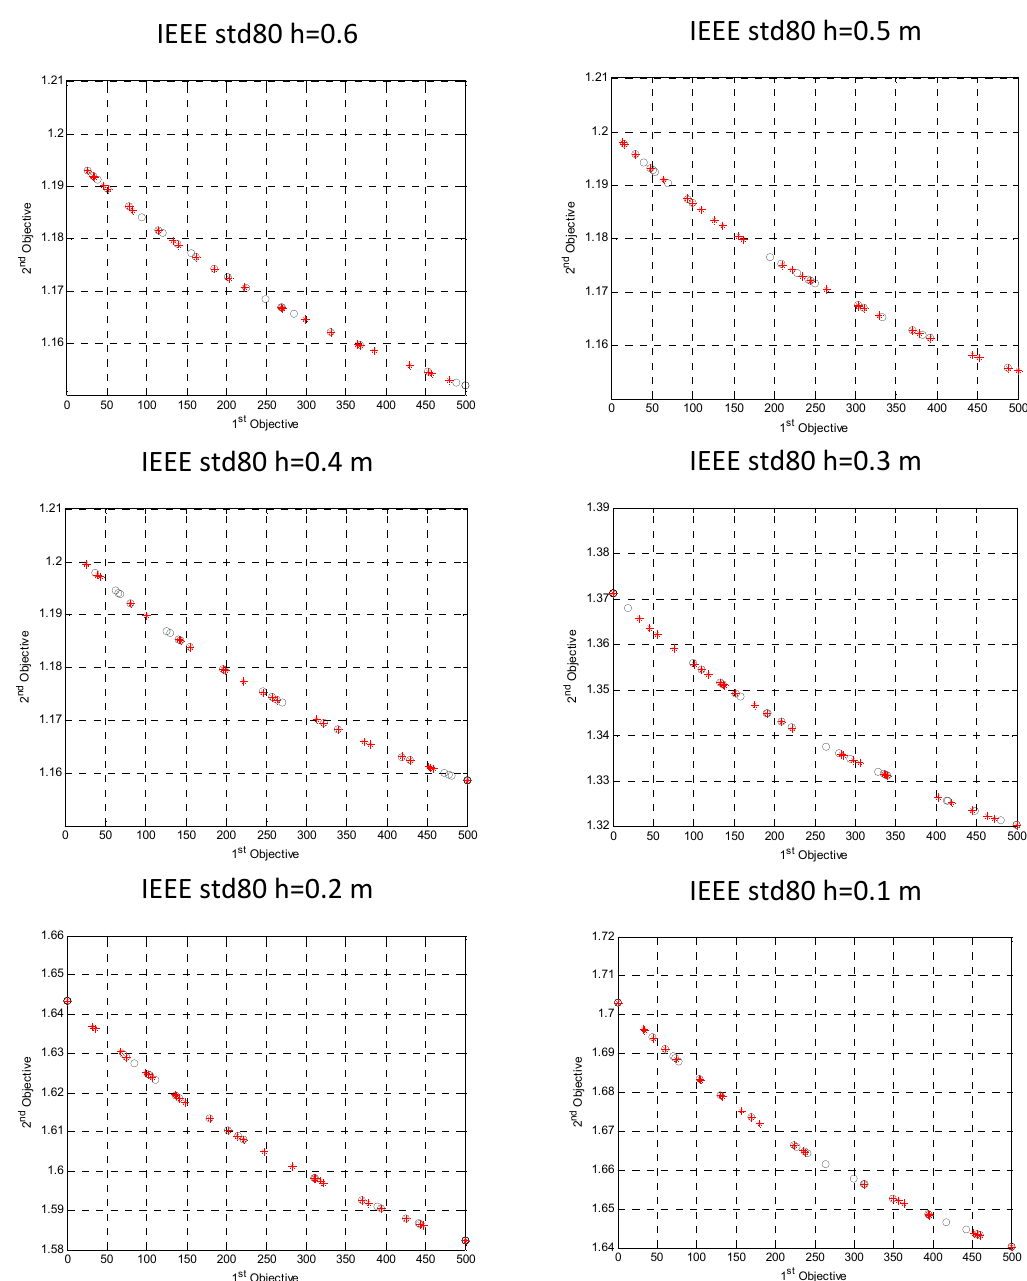
Figure 7. IEEE Std. 80-2000 adaptation function calculated by MOPSO at grounding grid depths of 0.1–0.6 m. The first objective is the number of grounding copper rods; the second objective is the trend of grounding resistance value ( Ω ) (red stars represent the local l best; black circles represent the global best).